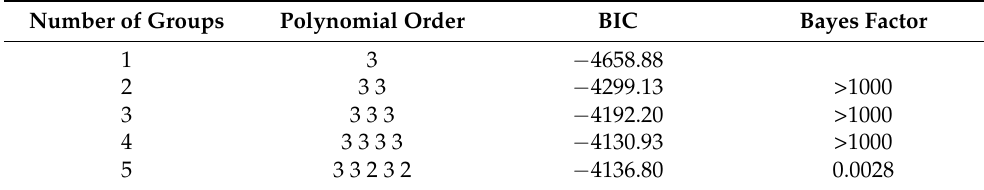
Table 3. Model selection results based on all available data points. Number of